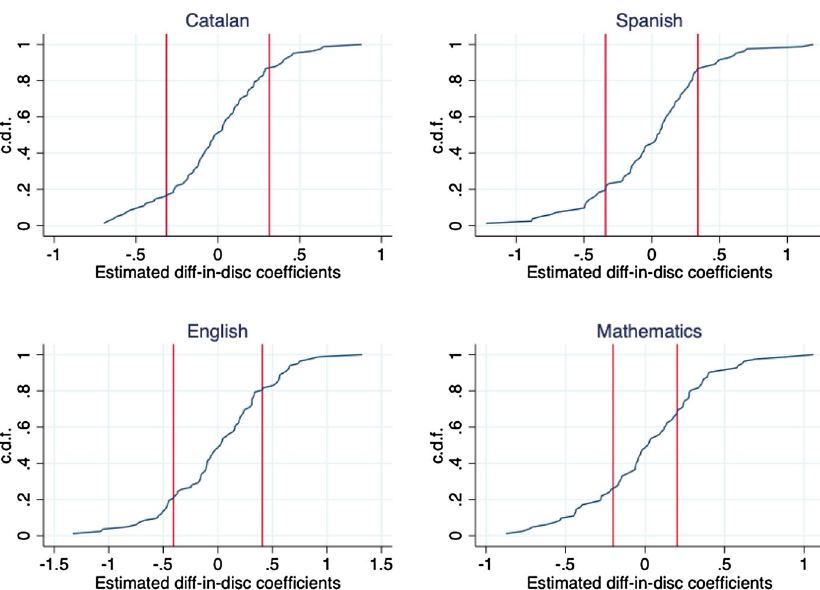
Fig. 7 Cumulative distribution functions of placebo cut-offs, boys in disadvantaged public schools. Note : For each subject, this figure reports the empirical cumulative distribution function of diff-in-disc estimates using fake cut-offs to the left (-80 to -40) and to the right (40 to 80) of the actual July 1 cut-off